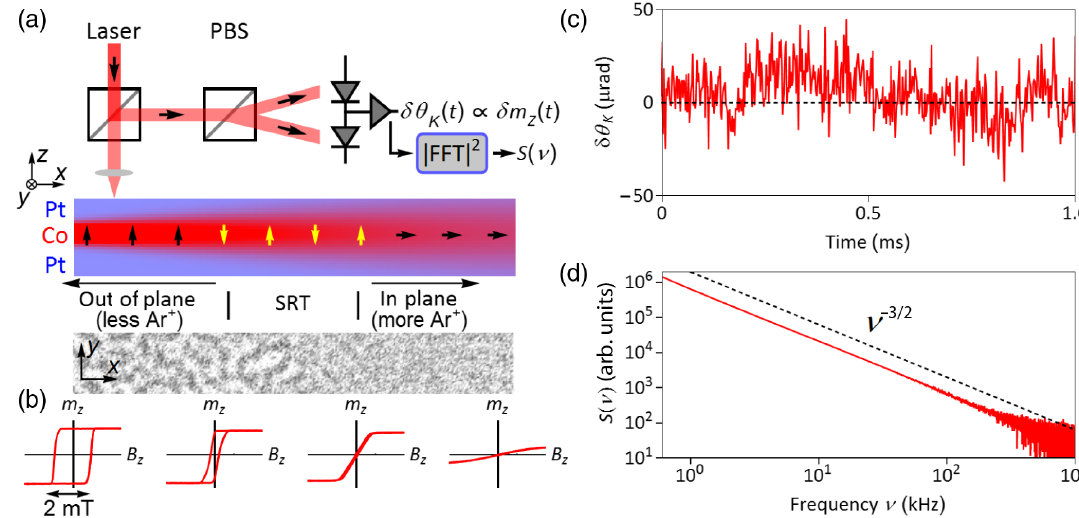
FIG. 1. (a) Experimental schematic. A scanning broadband optical magnetometer based on polar MOKE measures the spontaneously fluctuating out-of-plane magnetization δ m z ð t Þ within a small ( 4 μ m) spot on the sample. The power spectral density of this magnetization noise S ð ν Þ is continuously computed and averaged in real time (PBS: polarizing beamsplitter, FFT: fast Fourier transform). The sample is a Pt = Co = Pt trilayer irradiated with a laterally varying dose of Ar þ , generating a lateral gradient of interfacial magnetic anisotropy. Red and blue colors depict Co and Pt layers; arrows depict the net magnetization direction, with yellow arrows indicating the region where the spin reorientation transition (SRT) occurs. (b) The magnetic contrast image of the trilayer surface (adapted from Ref. [32]) shows the mazelike domain patterns that form in graded trilayers of this type. The patterns become blurry near the SRTas fluctuations increase and occur faster than the image acquisition time. Conventional MOKE magnetization measurements m z ð B z Þ show that the coercive field μ 0 H c → 0 as the SRT is approached. (c) Characteristic Kerr rotation fluctuations δθ K ð t Þ reveal the thermodynamic magnetization fluctuations δ m z ð t Þ . (d) S ð ν Þ falls as a ν − 3 = 2 power law over the measured 1 kHz – 1 MHz range in regions of the trilayer exhibiting perpendicular magnetization. Discussion of measurement uncertainties in this and subsequent figures can be found in the Supplemental Material